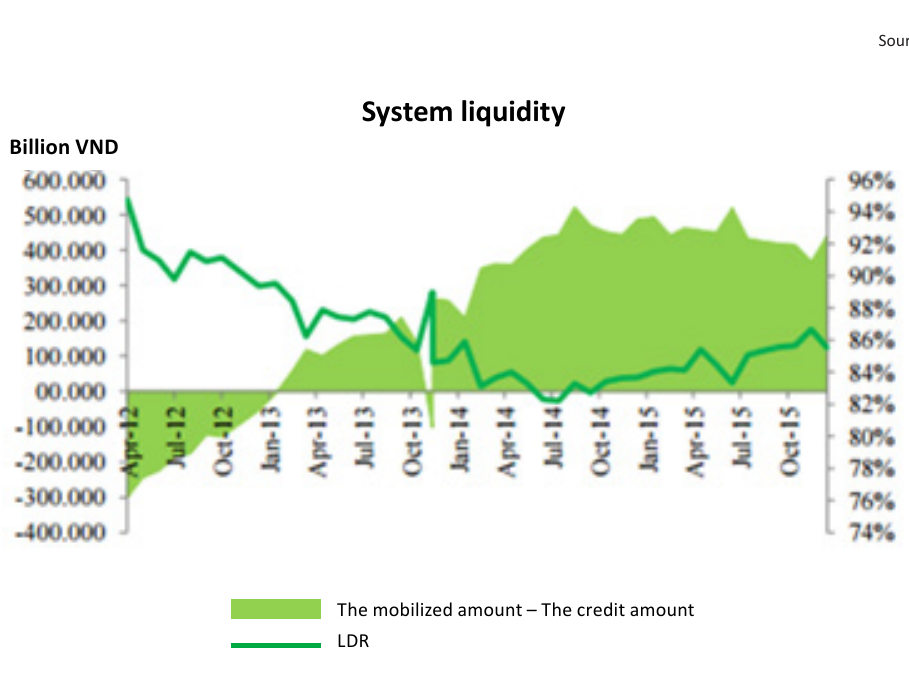
Figure B3. Liquidity of Vietnamese commercial banking system and LDR ratio